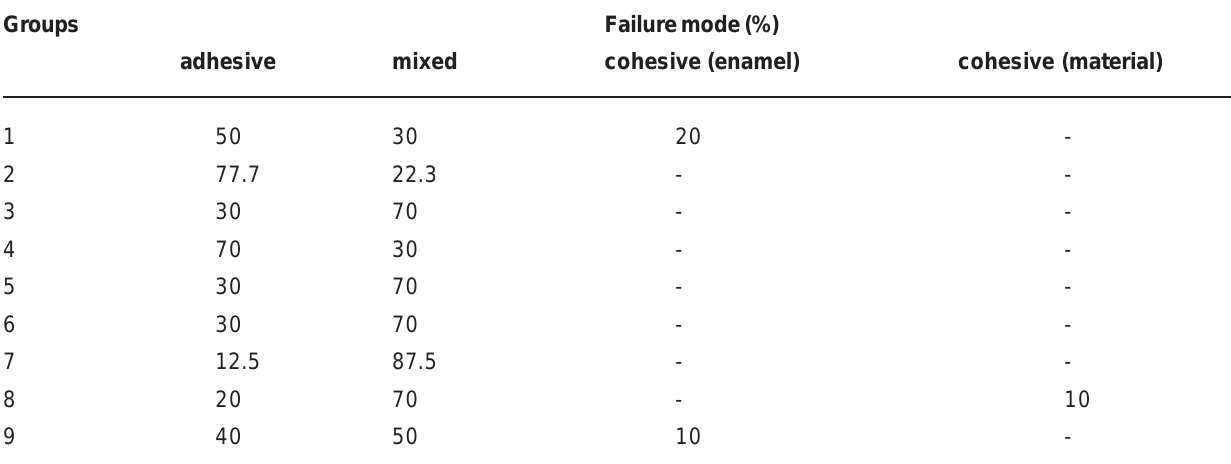
TABLE 3 - Distribution of failure modes (%) as determined under light microscope, 25X